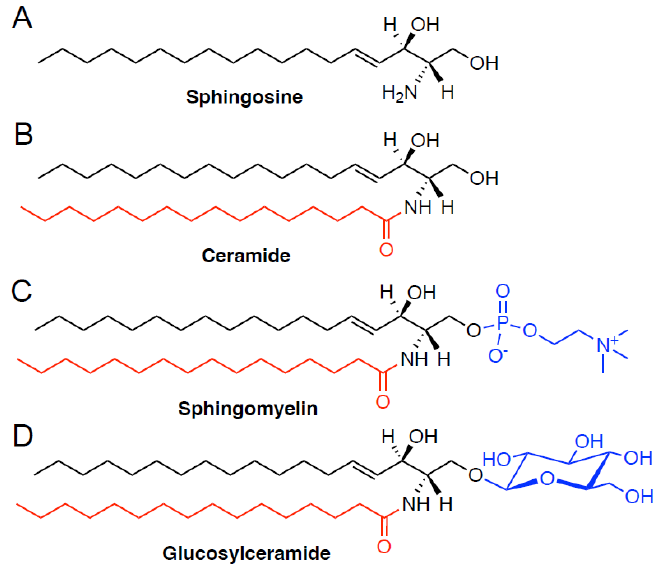
Figure 1. Structures of ceramides and other sphingolipids. ( A ) The most prevalent sphingoid base in mammals is a C18-sphingosine. General structures of ceramides ( B ), sphingomyelins ( C ) and glucosylceramides ( D ) on the C18-sphingoid backbone (black). Head groups of sphingomyelin and glucosylceramides are shown in blue. The acyl chain (red) length varies from 16 to 26 carbon-containing structures, predominantly in mammalian cells. C16 species are shown here as representative structures.